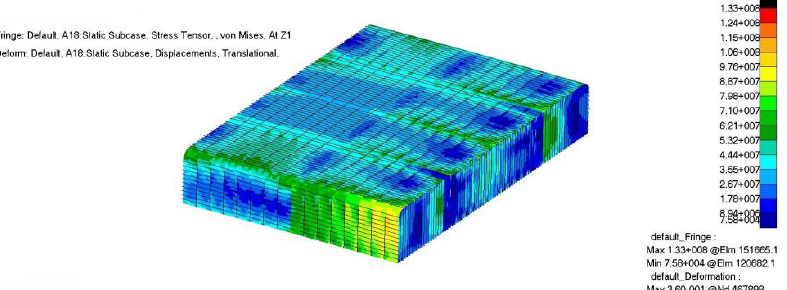
Figure 22. Stress contour plot of the bottom shell of the 4th and 5th cabins when just sitting on the sand.